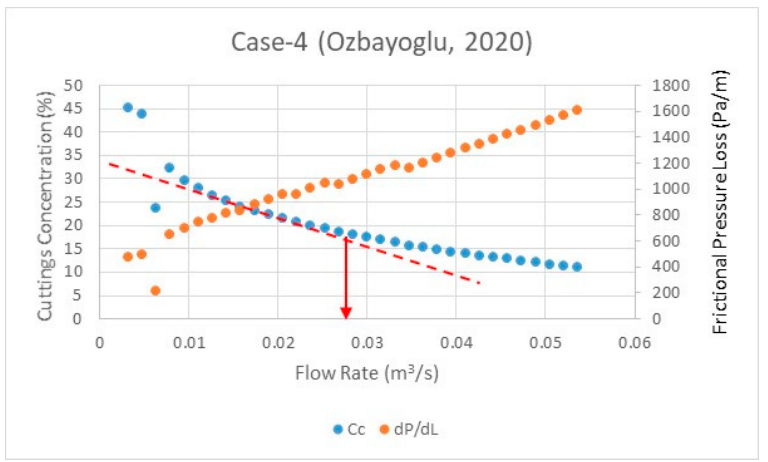
Figure 6. A sample analysis conducted to determine the optimum flow rate using Ozbayoglu’s model when the pipe rotation speed is 6.283 1/s.